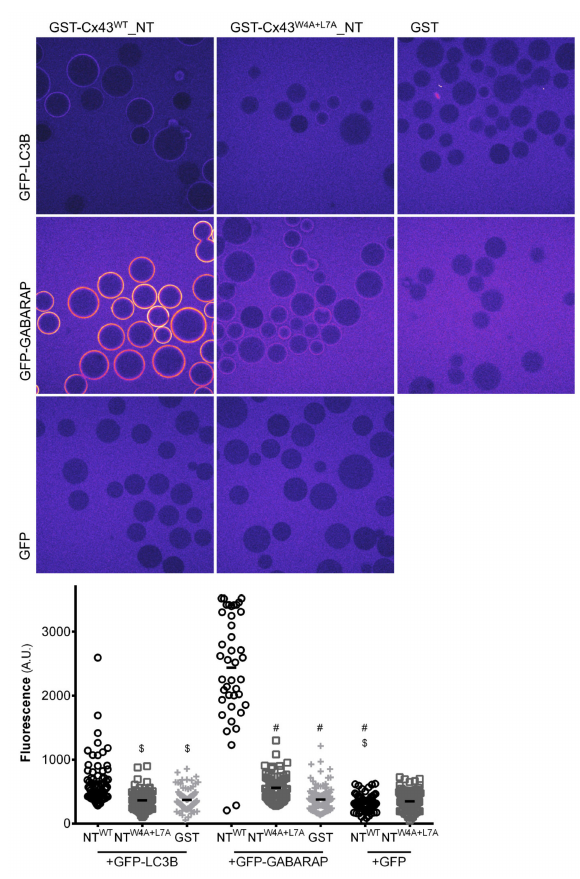
Figure 2. The LIR motif in the amino terminal of Cx43 interacts with GABARAP in vitro. Peptides comprising either the amino terminal of wild type (NT WT ) or W4A + L7A mutant (NT W4A + L7A ) Cx43 fused to GST were bound to glutathione beads and subsequently incubated with recombinant GFP-LC3B or GFP-GABARAP, after which the beads were transferred to a glass-bottom microplate and imaged using a confocal microscope. The GFP signal is shown in false colour (ImageJ: Fire). The intensity of the GFP signal surrounding the glutathione beads was measured and plotted in a graph. $ p < 0.0001 vs. NT WT + GFP-LC3B, # p < 0.0001 vs. NT WT + GFP-GABARAP using a Kruskal-Wallis test,